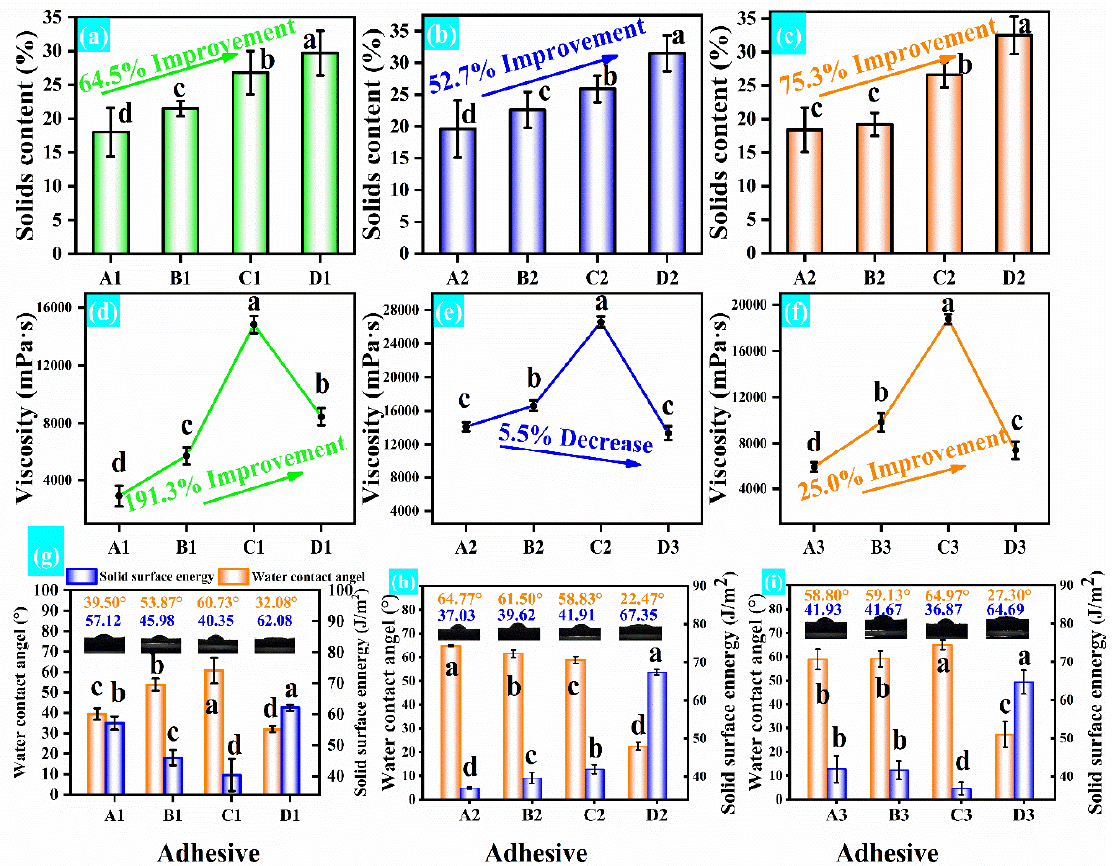
Figure 9. The ( a – c ) solids content, ( d – f ) viscosity, ( g – i ) water contact angle, and solid surface energy of A1 ‐ pure HPMP, B1 ‐ SDS/HPMP, C1 ‐ SDS/nSiO 2 /HPMP, D1 ‐ HPMP, A2 ‐ pure SBMP, B2 ‐ SDS/SBMP, C2 ‐ SDS/nSiO 2 /SBMP, D2 ‐ SBMP, A3 ‐ pure CSMP, B3 ‐ SDS/CSMP, C3 ‐ SDS/nSiO 2 /CSMP, and D3 ‐ CSMP adhesives.